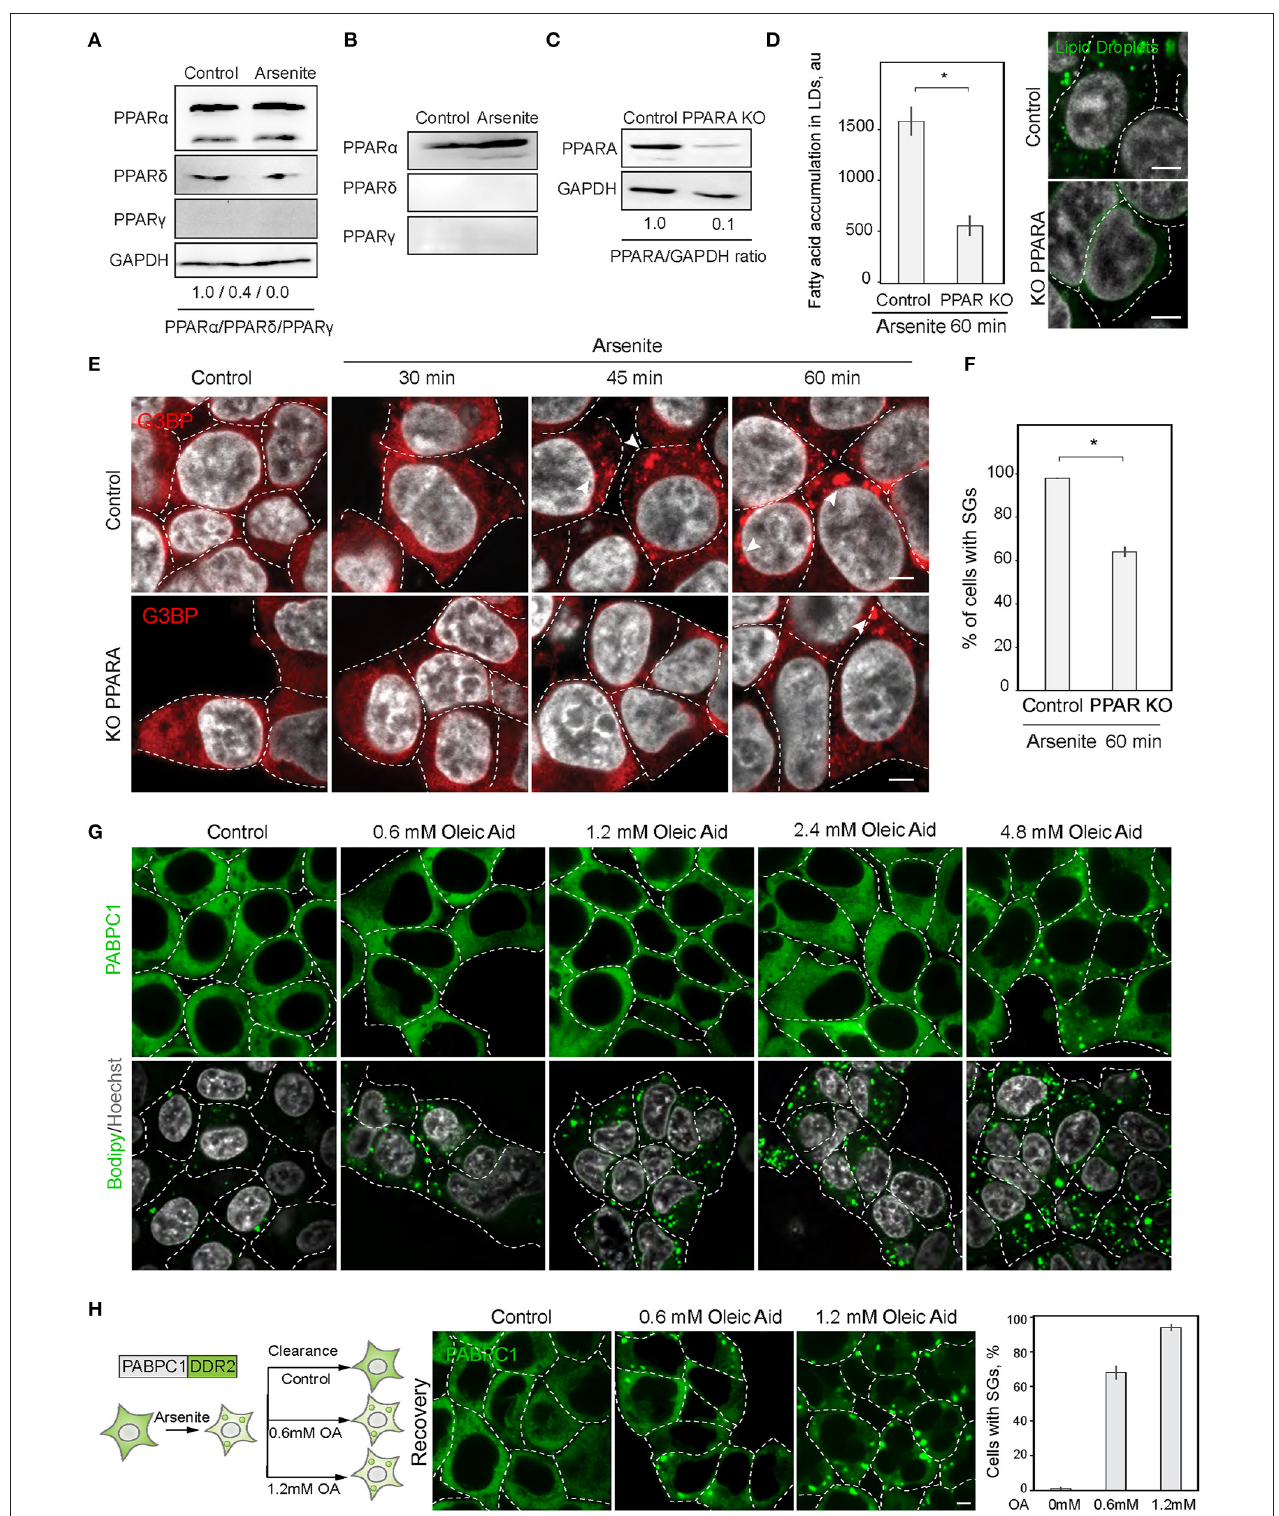
FIGURE 3 | PPAR alpha regulates SG formation. (A) PPARA isoform is prominent in SH-SY5Y cells. Cells were grown to 90% confluency. Control and arsenite-treated (100 µ M, 1h) cells were lysed and analyzed by western blot. (B) PPARA isoform is prominent in HEK293 cells. Cells were grown to 90% confluency. Control and arsenite-treated (100 µ M, 1h) cells were lysed and proteins were analyzed by western blot. (C) Verification of partial PPARA knockout (KO). (D) PPARA regulates LD